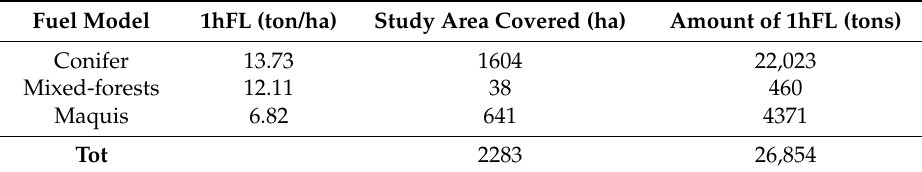
Table 2. The 1-h fuel load (1hFL) of the three customized fuel models derived from Elia et al. [20], the extent of the landscape (ha) covered by each fuel model and the amount of 1-h fuel load (ton) for the entire study area.